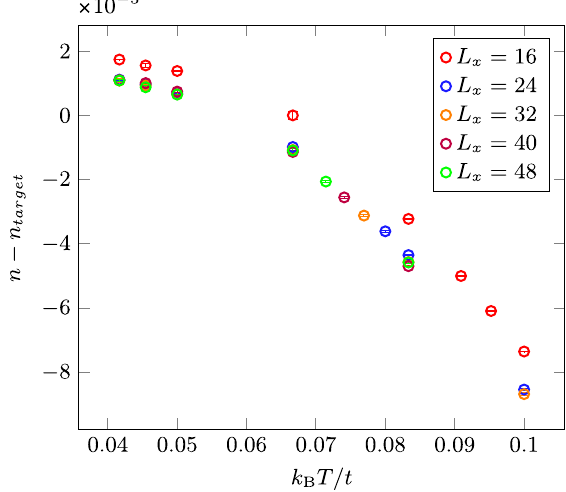
FIG. 20. The density over temperature for a given chemical potential μ ¼ − 0 . 6533 t at parameters U ¼ − 4 t and t ⊥ ≈ 0 . 28 t . The aspect ratio is chosen such that L